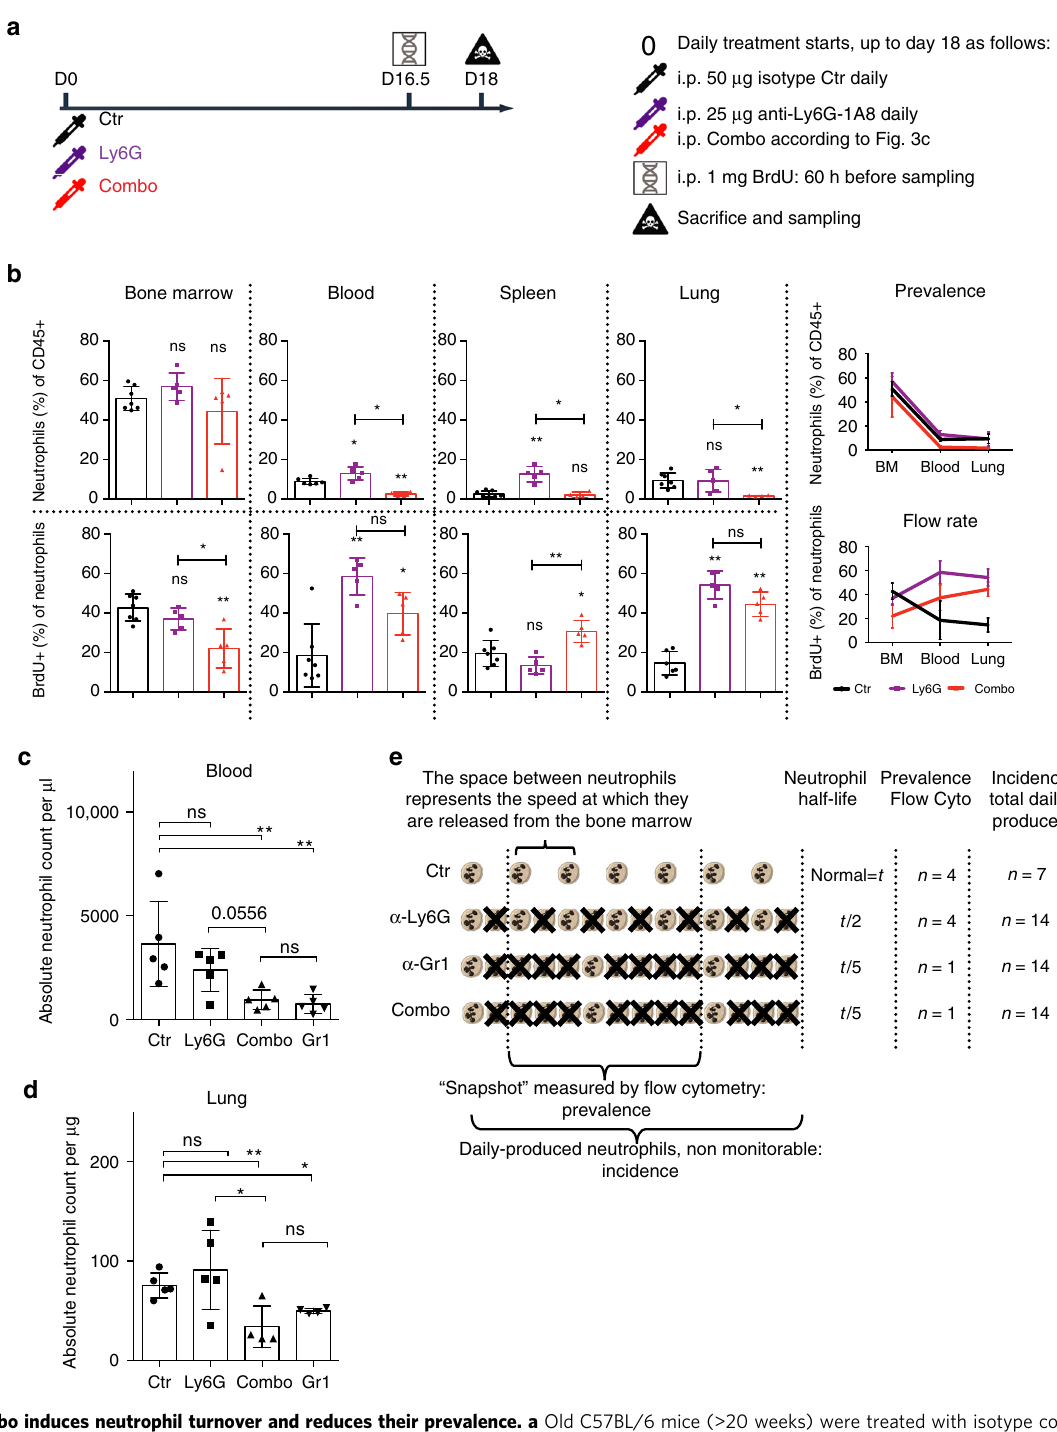
Fig. 4 Combo induces neutrophil turnover and reduces their prevalence. a Old C57BL/6 mice (>20 weeks) were treated with isotype control antibody (Ctr), anti-Ly6G or the combination strategy (Combo) for 18 days. 60 h before sampling, mice were injected once with 1 mg of BrdU intraperitoneally. b Neutrophil prevalence among all immune cells was assessed in bone marrow, blood, spleen and lung while the impact on their dynamic fl ow rate was measured with BrdU-60h labelling. Both anti-Ly6G and Combo treatment elicit a shift of BrdU neutrophils from the bone marrow stock to the peripheral tissue, but only the Combo treatment is “ fast ” enough to also reduce neutrophil prevalence. BM, bone marrow. c , d Validation of protocol ef fi cacy with Trucount fl ow cytometry analysis in ( c ) blood and ( d ) lung tissue. e Scheme representing neutrophil counts in the circulation from a dynamic perspective, with the impact of increased fl ow rate on the global prevalence of neutrophils depending on the killing celerity of the depletion strategy. * p < 0.05, ** p < 0.01 from Mann – Whitney test; error bars represent s.d. b n = 7 control (Ctr) and 5 treated mice per group. c , d n = 5 mice per group. Source data are provided as a Source Data fi